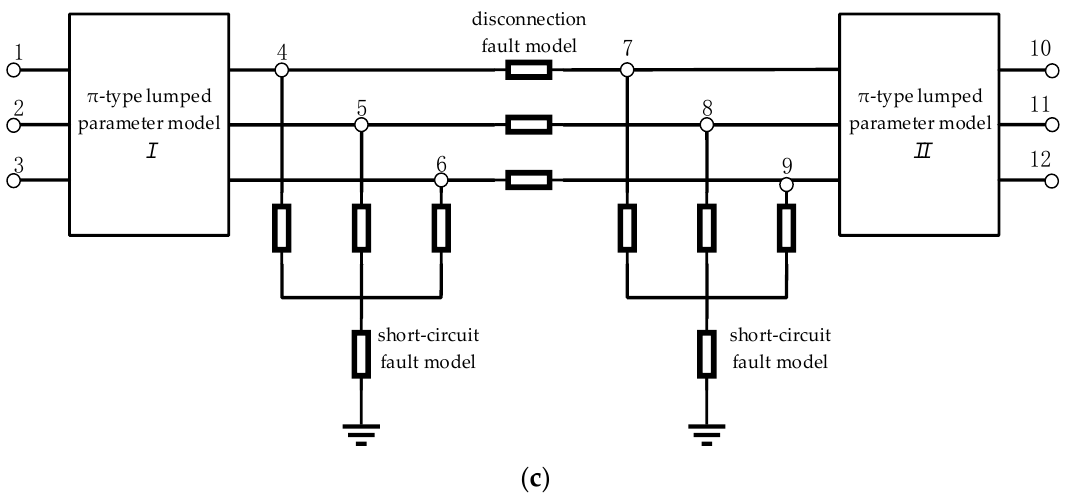
Figure 7. Composite units commonly used in power systems. ( a ) Interval unit; ( b ) transformer unit; ( c ) line unit with programmable faults.